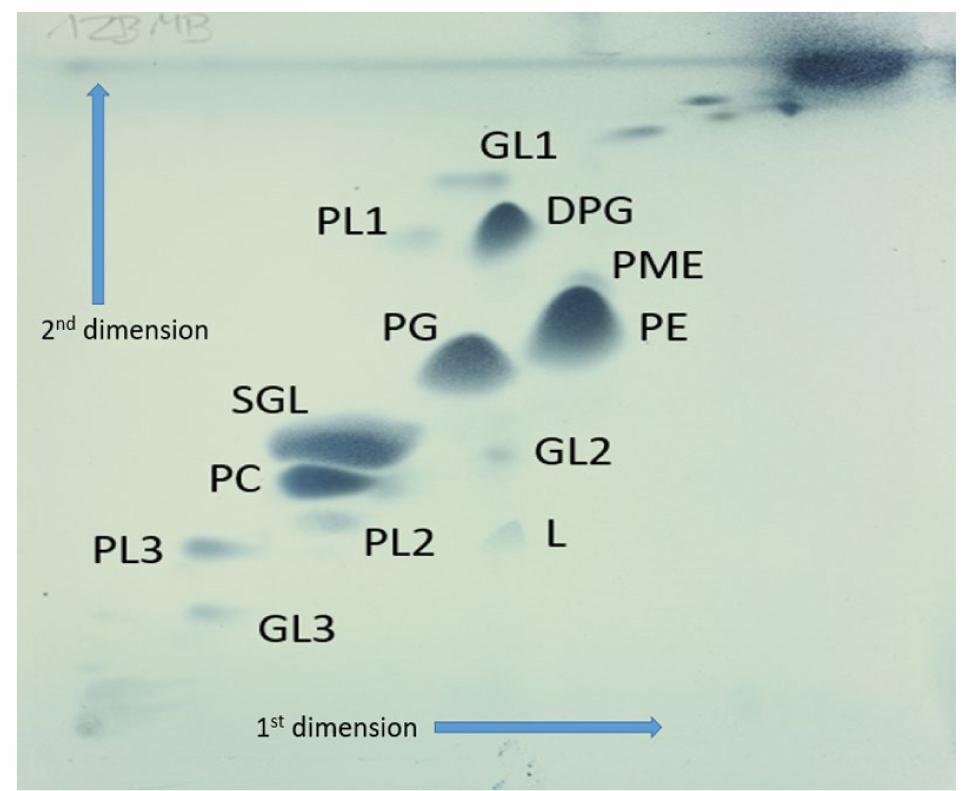
Figure 3. Polar lipids observed in strain NZ-12B T are DPG: diphosphatidylglycerol; PE: phos- phatidylethanolamine; PME: phosphatidyl-N-methyl-ethanolamine: PC: phosphatidylcholine; SGL: sphingoglycolipid; PG: phosphatidylglycerol; L: one unknown polar lipid; PL: three unknown phospholipids, and GL: three unknown